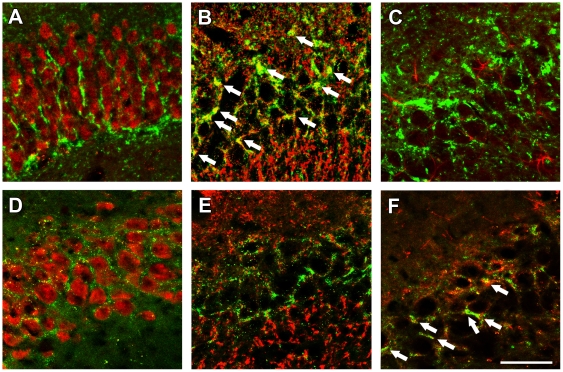
GABA transporter subtypes double labeled with neuronal and glial markers in hippocampal sections.GAT-1 (A–C) and GAT-3 (D–F) are labeled with green while NeuN (A, D), synaptophysin (B, E), and GFAP (C, F) are red. The yellow labeling in B and F demonstrate co-localization of GAT-1 with synaptophysin and GAT-3 with GFAP (some colocalization sites are marked by arrows). Scale bar  = 50 µm.